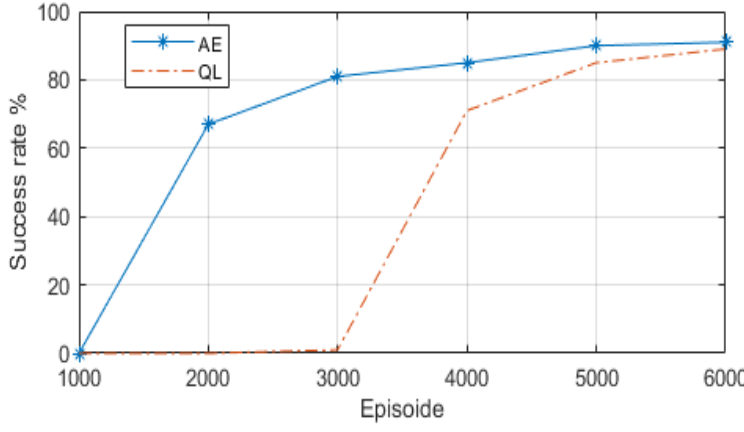
Figure 7. Rewards and average rewards of QL and AE.